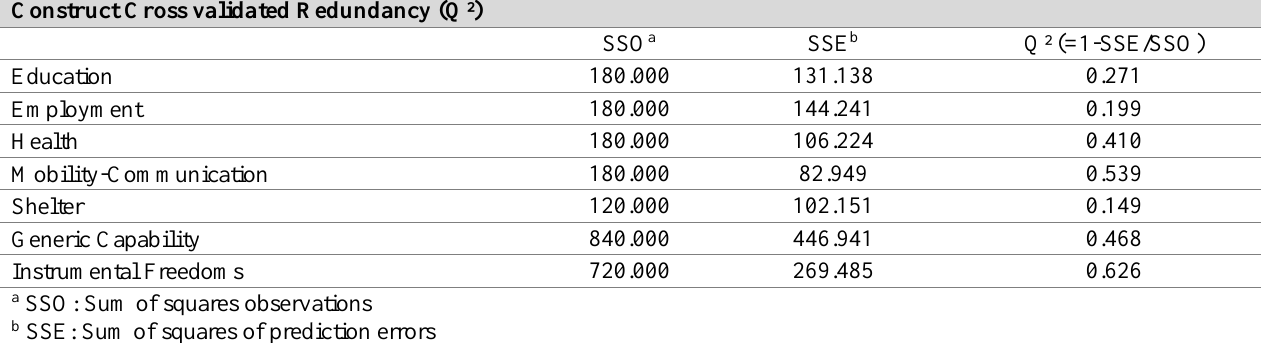
a SSO: Sum of squares observations b